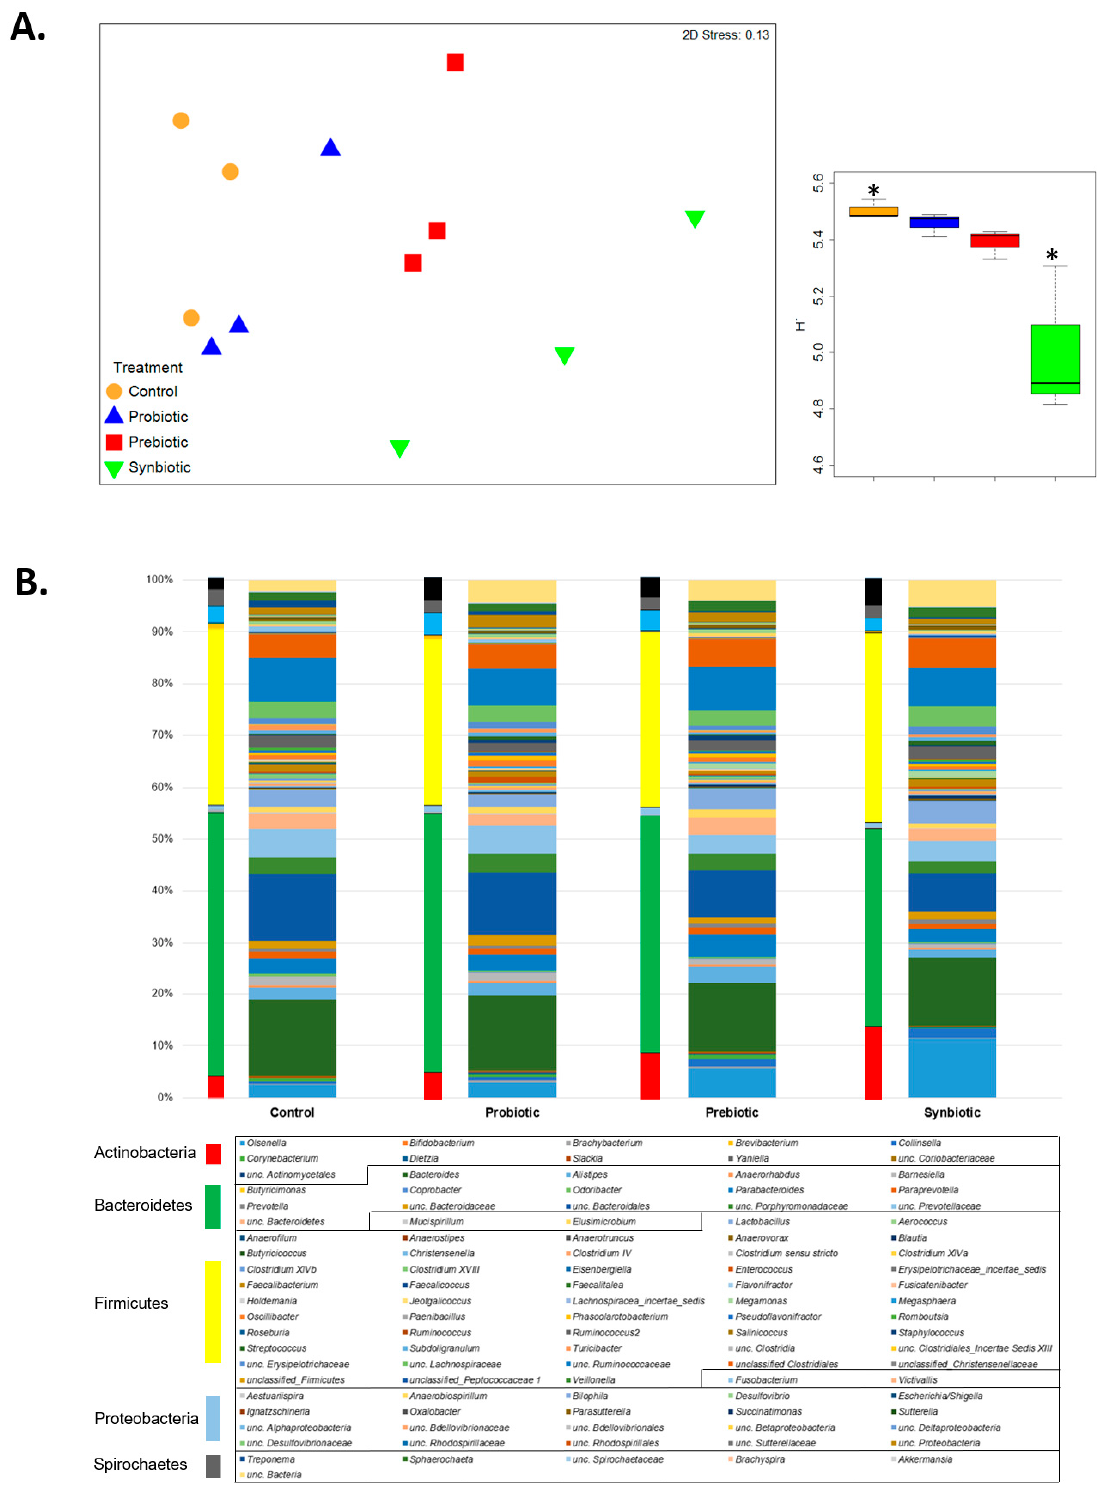
Figure 1. ( A ) Non-metric multidimensional scaling (nMDS) plot showing the distribution of the biological replicates on the diets. The diversity calculated with the Shannon index is plotted in the boxplot on the right bottom side. ( B ) Taxonomical information related to the 16S rRNA gene amplicon sequencing. The thinner bars indicate information at the phylum level and the wider bars indicate information at the genus level (average relative abundance >1%).